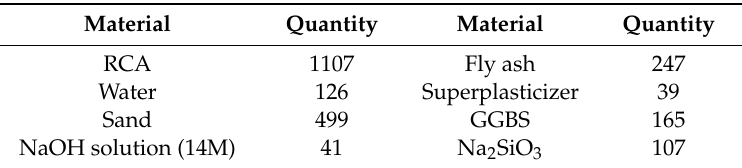
Table 4. Mix design of GRAGC (kg / m 3